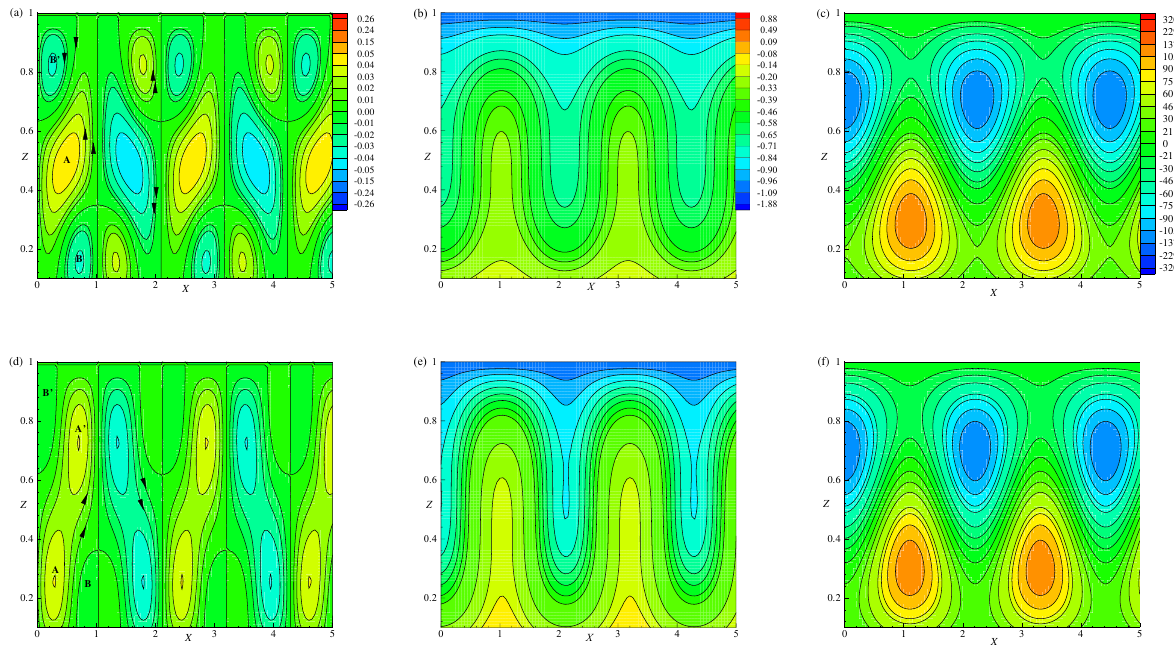
Figure 10. Streamlines ( left ), isotherms ( middle ) and isoconcentration lines ( right ) for Le = 0.05 ( a – c ) and 0.04 ( d – f ) with ψ = − 0.01, χ = 0.4, t = 0.1 and R = 3 R co . Figure 11 illustrates the pattern of streamlines, isotherms and isoconcentration lines for distinct values of t with R = 3 R co , ψ = − 0.01, χ = 0.4 and Le = 0.06. Figure 11a represents the pattern of streamlines for t = 1.1 and have the absolute maximum and absolute minimum values of circulation strength 1.07184 and − 1.07222, respectively, in the range of 0 ≤ X ≤ 1. The streamlines are of parallel concentric roll patterns, thus indicating the stable fluid flow at t = 1.1. Figure 11d shows the pattern of streamlines for t = 1.6 for the same values of other physical parameters that are considered in Figure 11a. The absolute maximum and absolute minimum values of circulation strength are 0.2809 and − 0.28082, respectively. The stable primary cells have been deformed and two new vortices are generated inside the primary cell, namely, B and B (cid:48) , with an absolute minimum value of circulation strength as − 0.257. The isotherms plotted in Figure 11b,e are for the same physical parameters that are considered in Figure 11a,d, respectively. Figure 11b shows the isotherms that appeared in the form of plumes in the middle region of the temperature field. As t increases from 1.1 to 1.6, the size of the plume structure increases vertically.